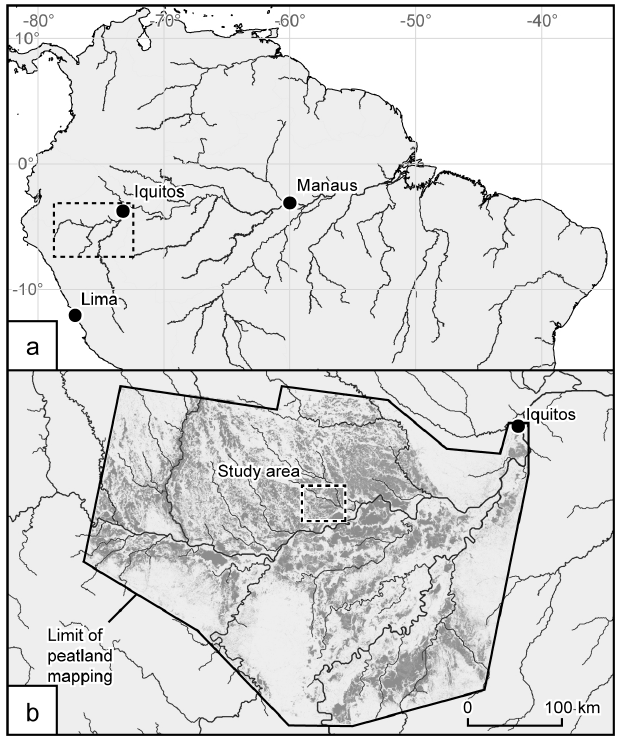
Fig. 1 . (a) Location of the Pastaza-Marañón Basin in western Amazonia (dashed box); (b) inset showing the Pastaza- Marañón Basin, with the modeled distribution of peatlands following Draper et al. (2014) in gray. The study area, around the Chambira River basin, is